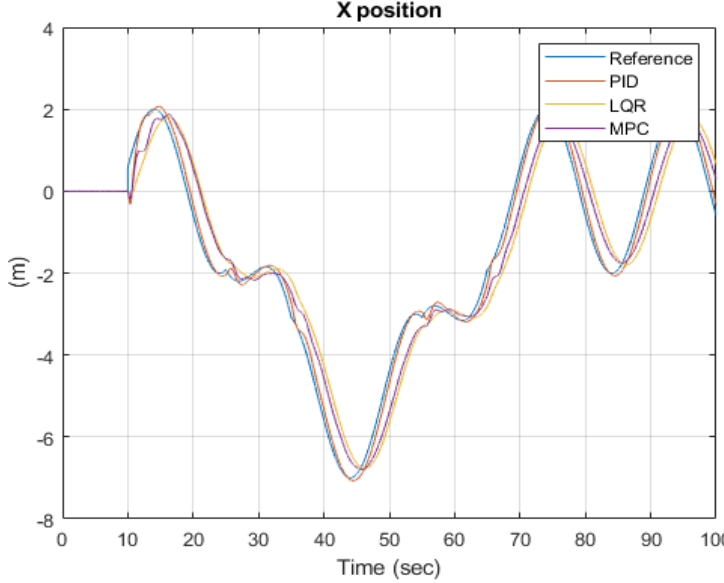
Figure 4. Performance of the controllers along x axis in simulation.